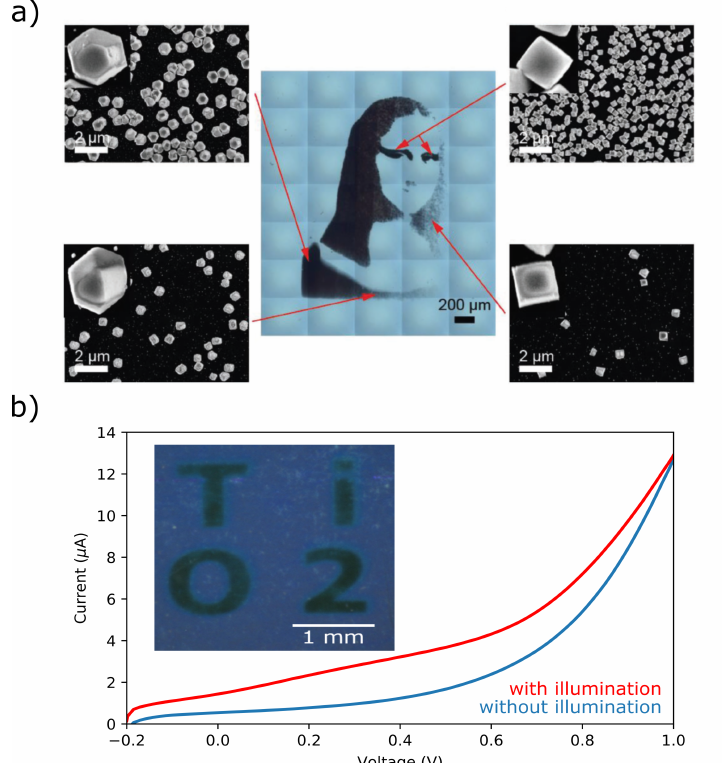
Figure 9. ( a ) Partial deposition of Cu 2 O by top-side illumination with a Ferroelectric Liquid Crystal on Silicon (FLCoS) display under various conditions to influence the particles’ shape and cubicity. ( b ) Snippet of the first potentiodynamic cycle with and without rear-side illumination during the polymerization of pyrrole on TiO 2 . In the inset, the deposited “TiO2” letters on the surface is shown. Part (a) is used with permission from Vogel et al. [109] Copyright (2020)